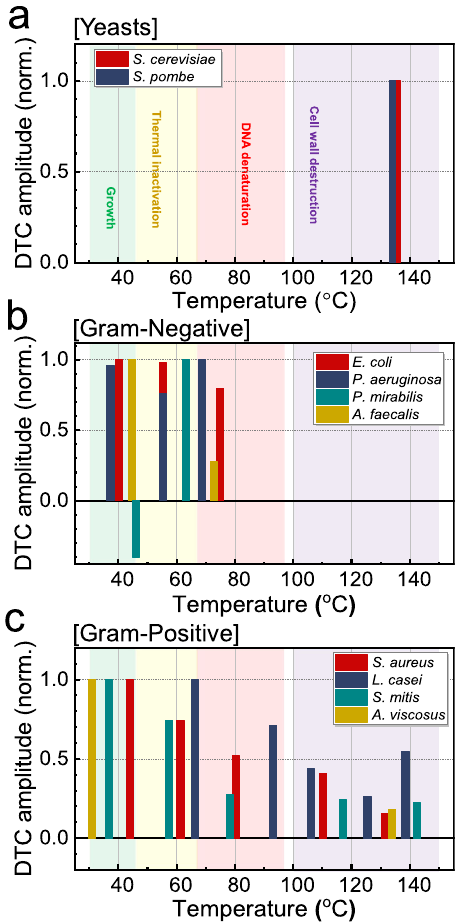
Fig. 4 Summary on the thermal curve analysis for 10 pathogens. Bar graphs of amplitude as a function of temperature according to the peaks observed in DTCs for a yeasts, b Gram-negative bacteria, and c Gram- positive bacteria. The amplitudes are normalized by its highest peak values for each species.